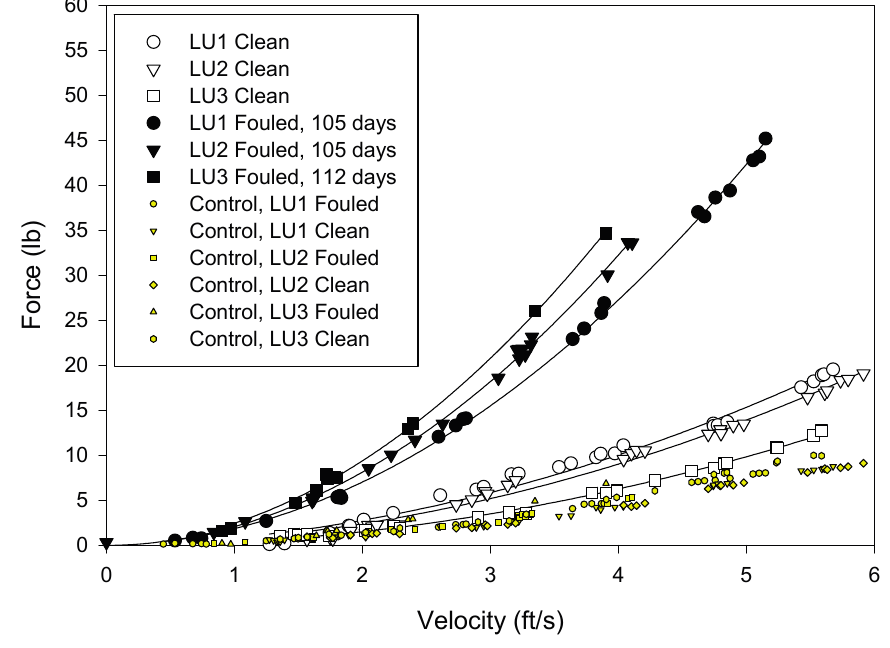
Figure 6. Drag forces measured on the copper coated nets. White filled symbols represent clean nets and black filled symbols represent fouled nets. Shaded points without regression lines are the force readings on the control force gage (blank